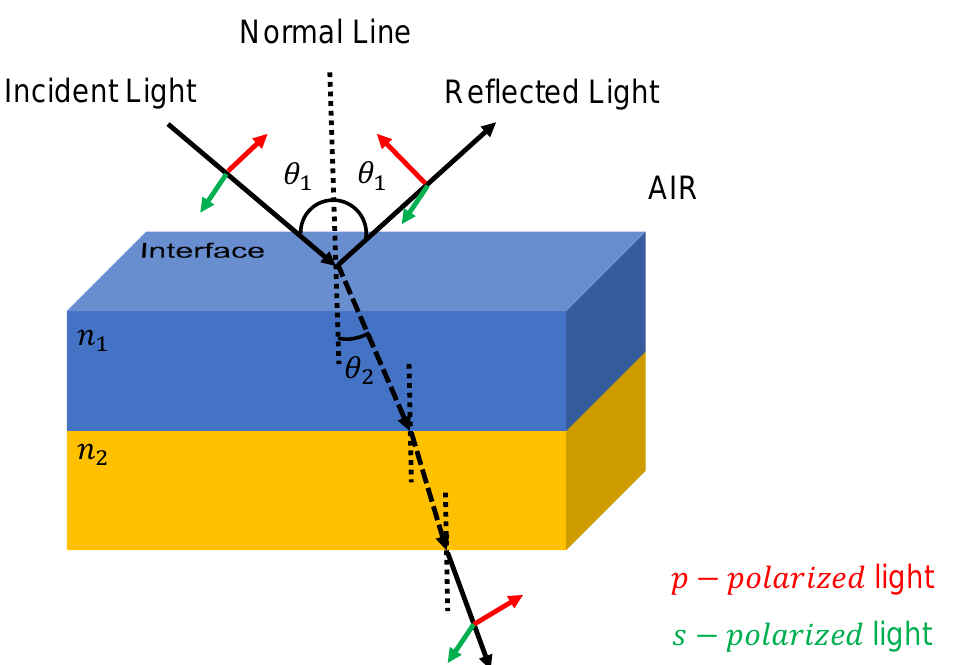
Figure 3. Diagram of the p -polarized light and s -polarized light. The electronic field of p -polarized light is parallel to the plane of the incident light, while the s -polarized light is perpendicular to the incident plane. For convenience, we refer the n 1 and n 2 as the refractive index for two differ- ent